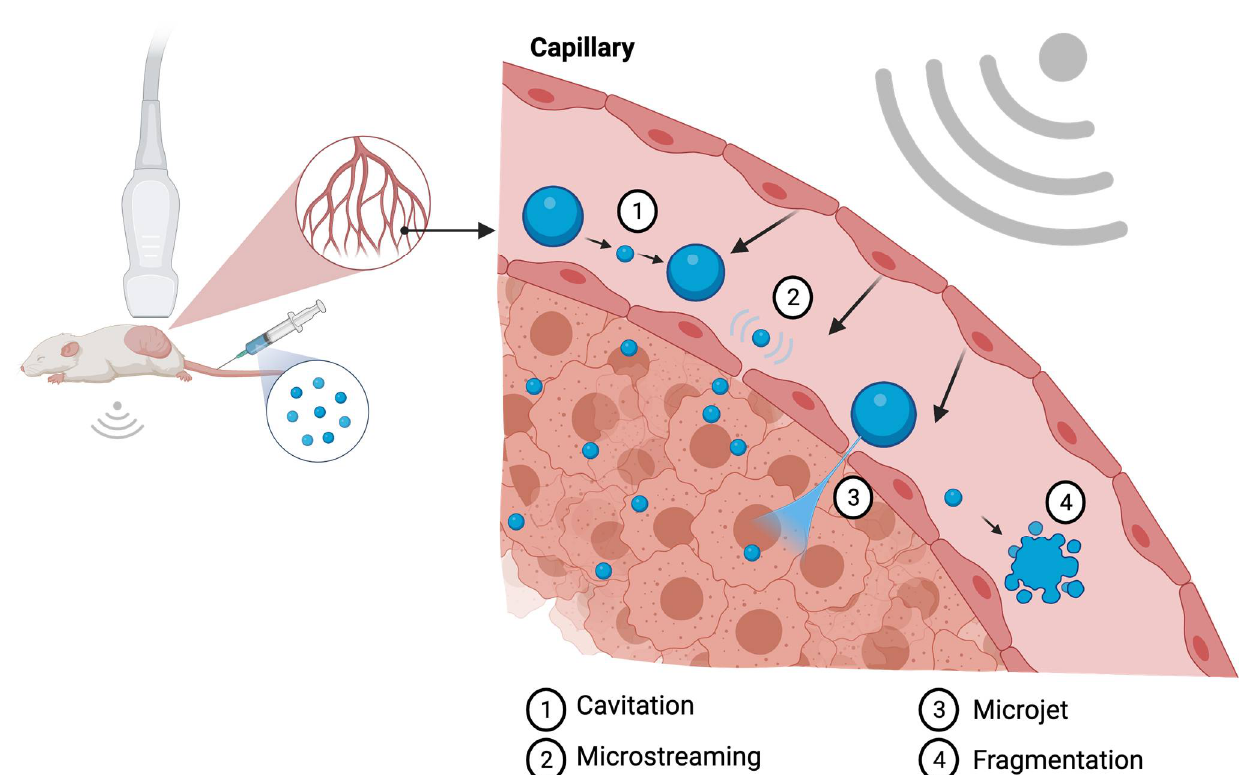
Figure 1. Illustration of the biologic effects of MBs sonification at the capillary level. The cavitation process (1) represents the change in MB diameter reflecting in expansion and shrinking resultant of acoustic pressure variation. Microstreaming (2) is regarded as one of the major biological effects able to induce pore formation through a process of microshearing. Microjet formation (3) and fragmentation (4) are the mechanisms observed at the maximal expansion phase of the cavitation process. Created with BioRender.com.